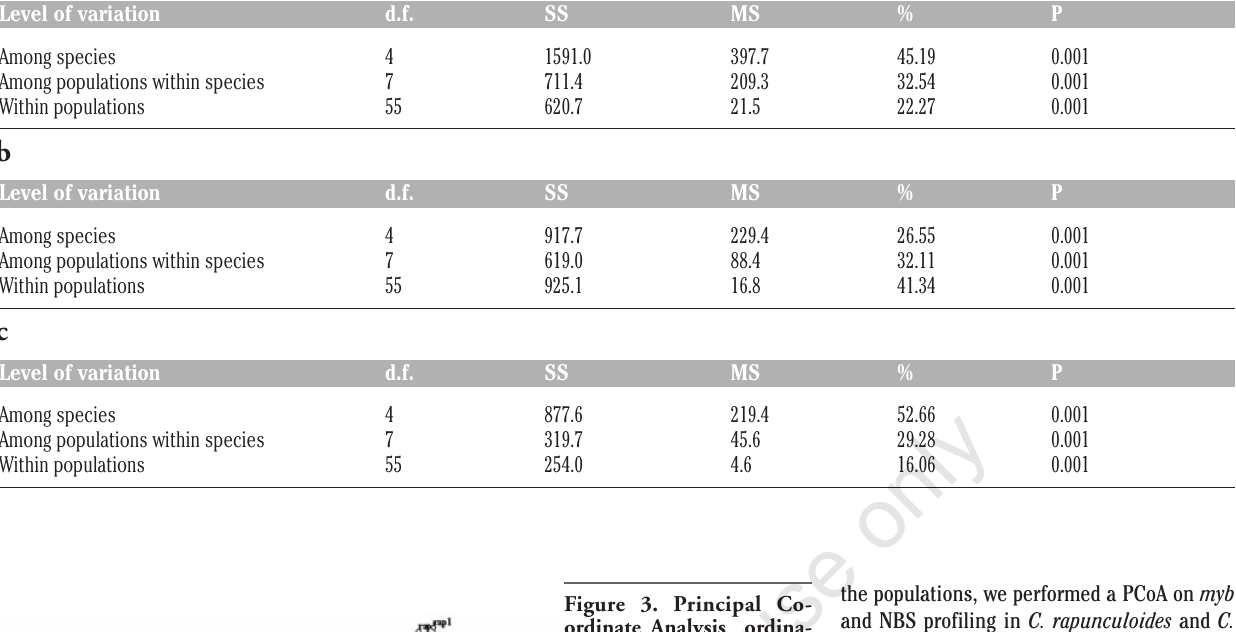
Figure 3. Principal Co- ordinate Analysis ordina- tion of first, second, and third principal compo- nents of genetic similarity among C. rapunculoides accessions based on myb and NBS profiling data.